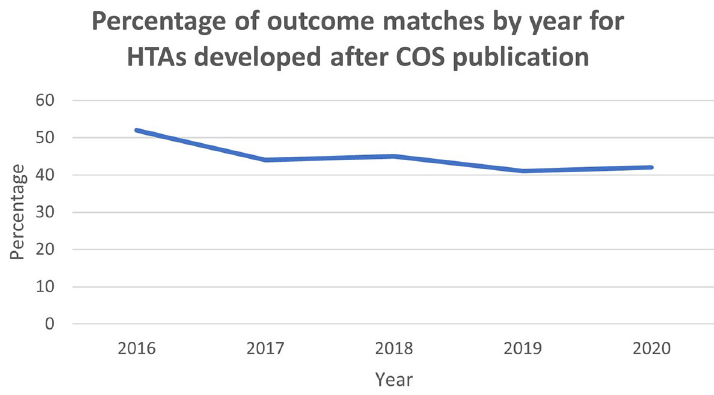
Figure 3. Percentage of outcome matches by year for HTAs developed after COS